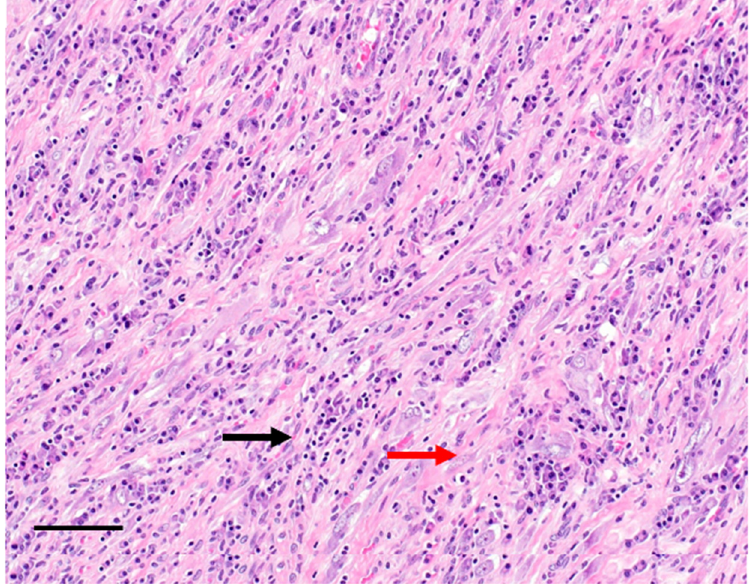
Figure 1. Hematoxylin eosin stain of an inflammatory myofibroblastic tumour composed of myofibroblast cells (red arrow) and inflammatory infiltrates (black arrow). Bar = 20 µm.